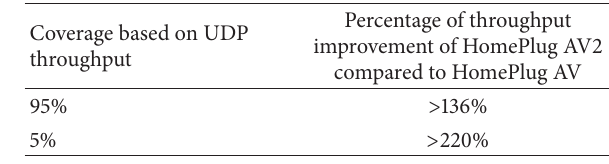
Table 1: Improvement of HomePlug AV2 in a 2-node network.